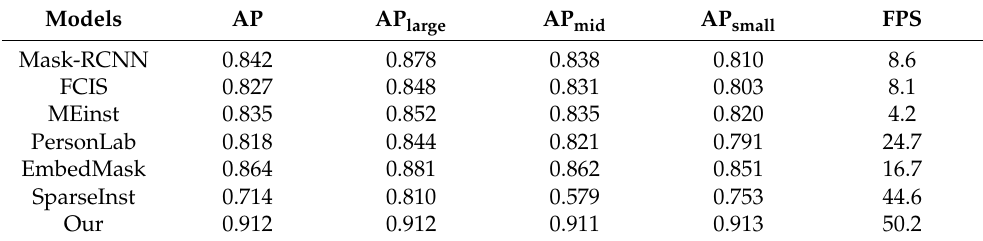
Table 3. Comparison of Overall Performance of Different Models.